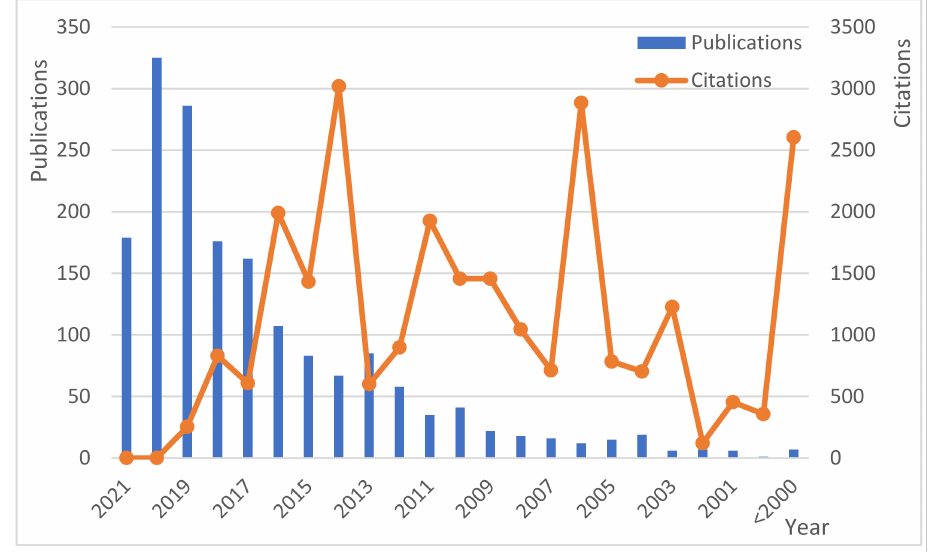
Figure 1. Publications and paper citations since 2000 in Scopus.